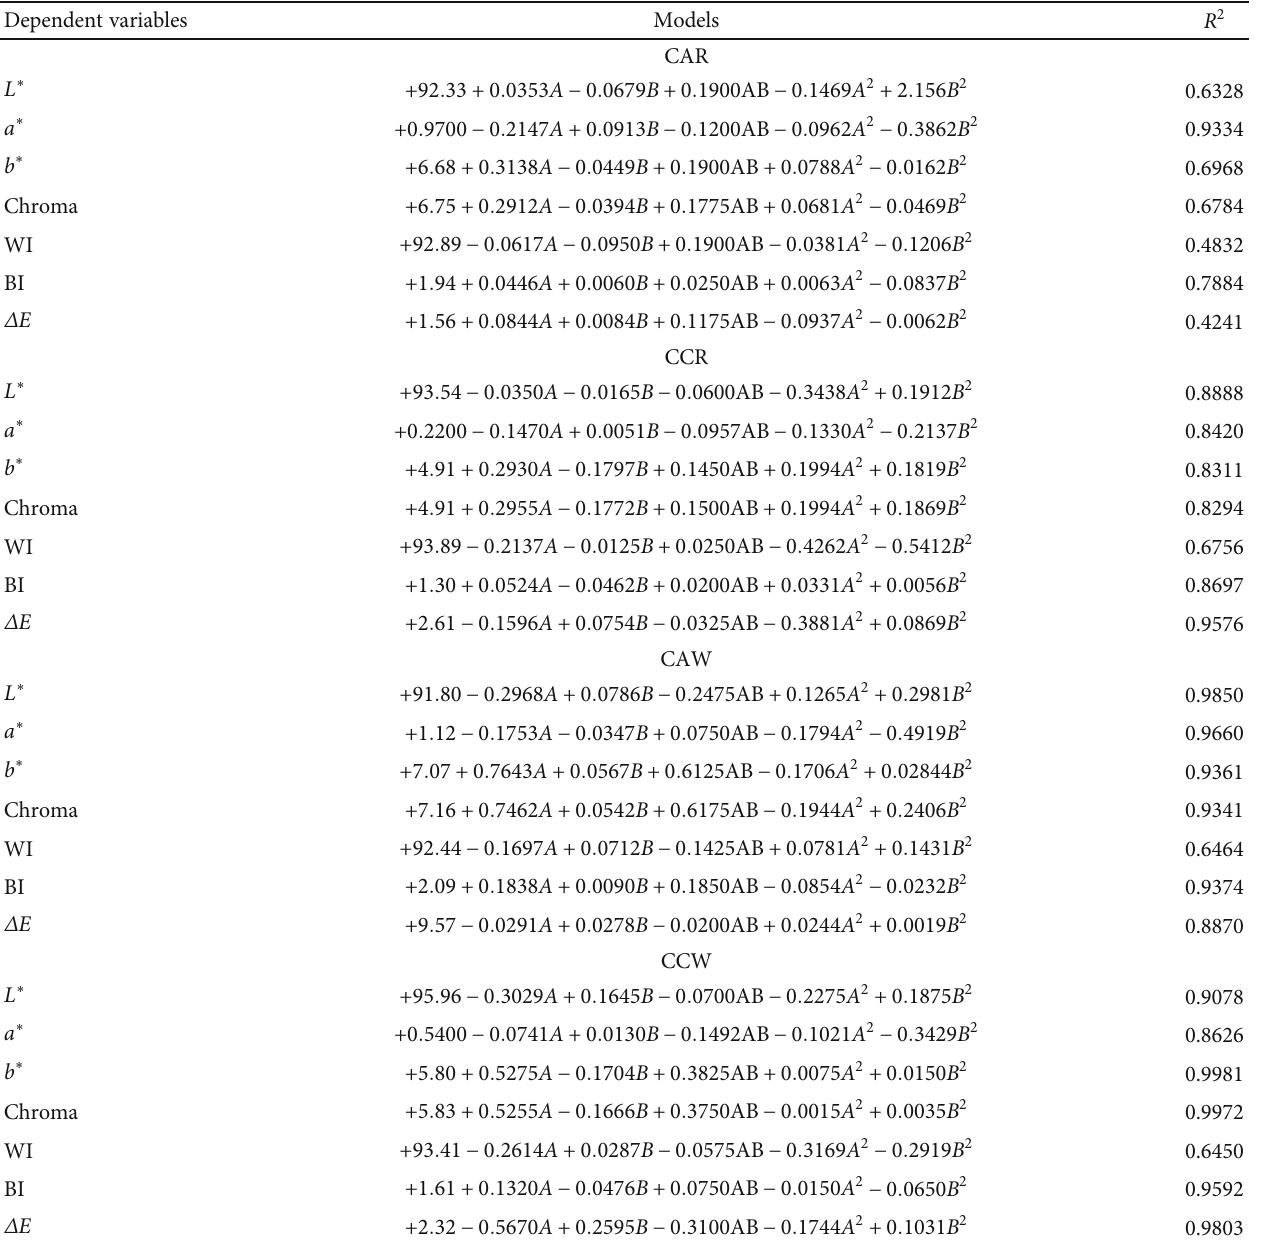
Table 6: Regression models relating model parameters and colour properties of cassava fl